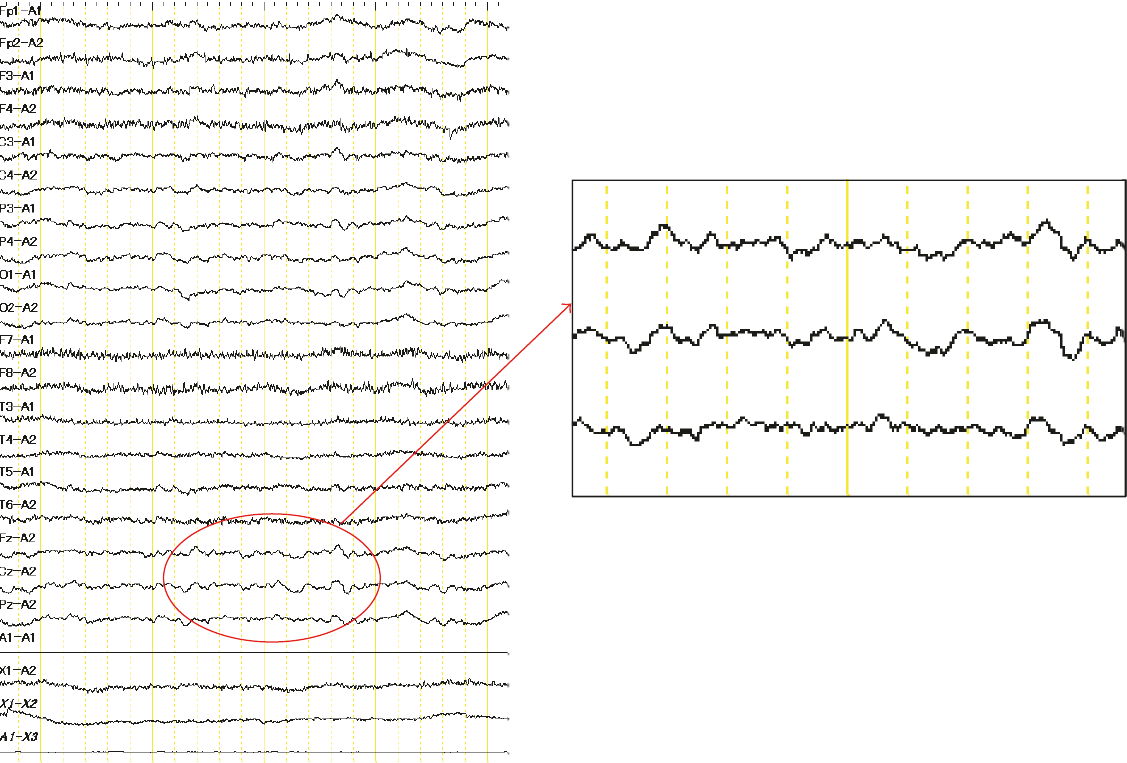
Figure 2: Electroencephalogram taken on admission, showing frequent slow waves (circle).